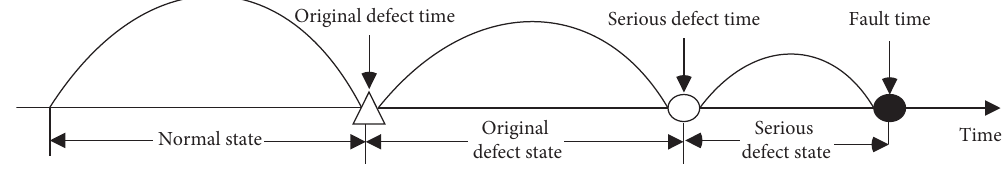
Figure 2: Three stages of